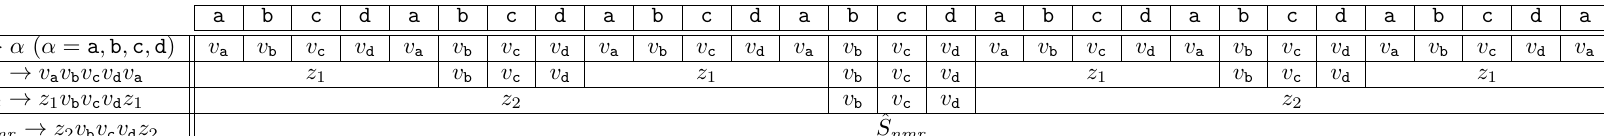
Figure A2. Grammar generation process of Naïve-MR-RePair and its generated grammar for the text ( abcd ) 7 a . The grammar size is 19.